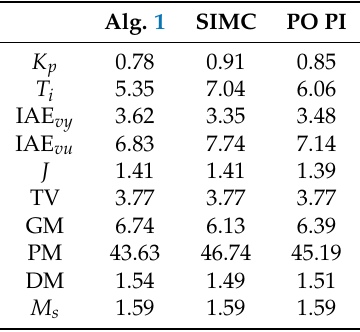
Table 10. Example 4. The table shows the PI controller parameters, indices and margins are given for prescribed robustness M s =